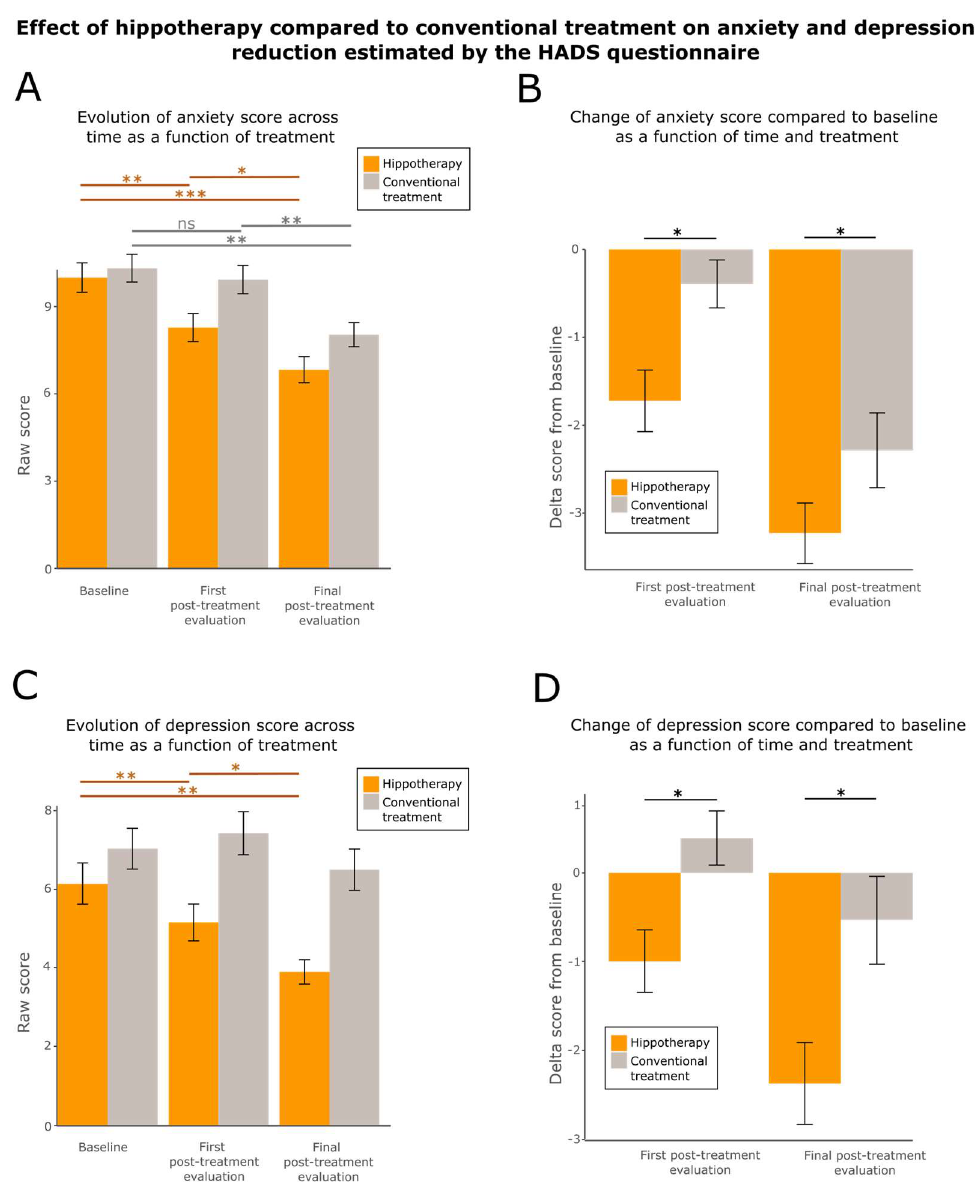
Figure 5. Effects of hippotherapy treatment compared to conventional treatment on anxiety and depression, as estimated by the HADS questionnaire. ( A ) Bar chart represents means (M) and standard errors of means (SEM) of the evolution of anxiety score across time as a function of the treatment type. Values (M ± SD) are as follows: Baseline = 10.0 ± 4.05, First post-treatment evaluation = 8.28 ± 3.87, Final post-treatment evaluation = 6.83 ± 3.56 for the hippotherapy group; Baseline = 10.3 ± 3.82, First post-treatment evaluation = 9.93 ± 3.91, Final post-treatment evaluation = 8.04 ± 3.33 for the control group. ( B ) Change of anxiety score compared to baseline score (M ± SEM), as a function of time and treatment. Values (M ± SD) are as follows: First post-treatment evaluation = −1.72 ± 2.80, Final post-treatment evaluation = −3.21 ± 2.78 for the hippotherapy group; First post-treatment eval- uation = −0.393 ± 2.18, Final post-treatment evaluation = −2.30 ± 3.47 for the control group. ( C ) Bar chart represents means (M) and standard errors of means (SEM) for the evolution of the depression score across time as a function of the treatment type. Values (M ± SD) are as follows: Baseline = 6.14 ± 4.28, First post-treatment evaluation = 5.14 ± 3.74, Final post-treatment evaluation = 3.89 ± 2.47 for the hippotherapy group; Baseline = 7.04 ± 4.15, First post-treatment evaluation = 7.43 ± 0.39, Final post-treatment evaluation = 6.5 ± 4.21 for the control group. ( D ) Change of depression score com- pared to baseline score (M ± SEM), as a function of time and treatment. Values (M ± SD) are as follows: First post-treatment evaluation = −1.0 ± 2.81, Final post-treatment evaluation = −2.29 ± 3.70